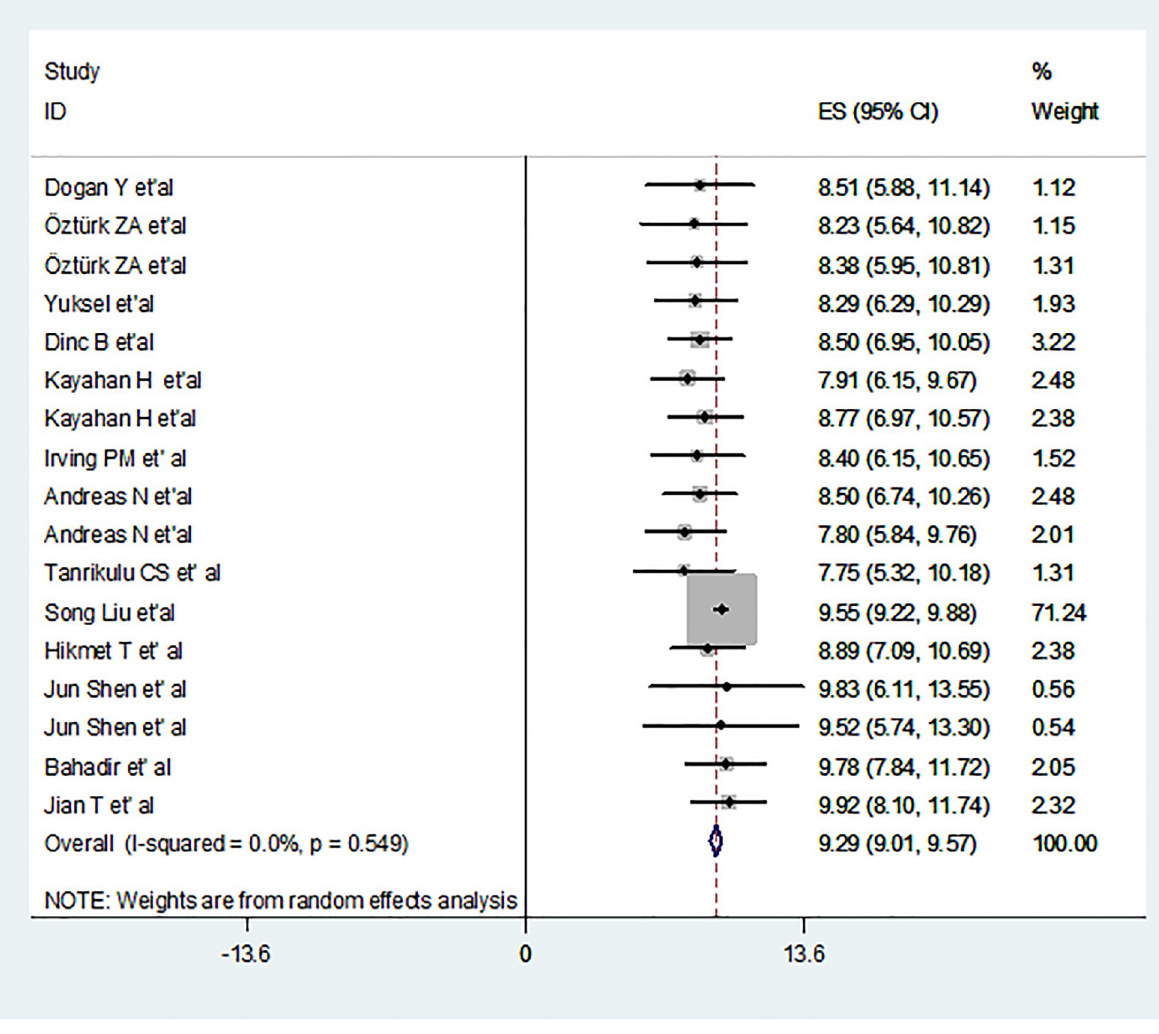
Fig 3. Forest plot of pooled estimated MPV in IBD patients using random effect model. The size of the x-axis shows the estimate pooled MPV of the studies. In the pooled point calculation, the dotted line represents the MPV. The black dot in the middle of the gray box reflects the estimate pooled MPV of each studies point and the line shows the 95% CI of the estimates. The gray boxes represent each study weight that contributes to the estimation of the pooled MPV. I-squared illustrates the heterogeneity between the included studies.